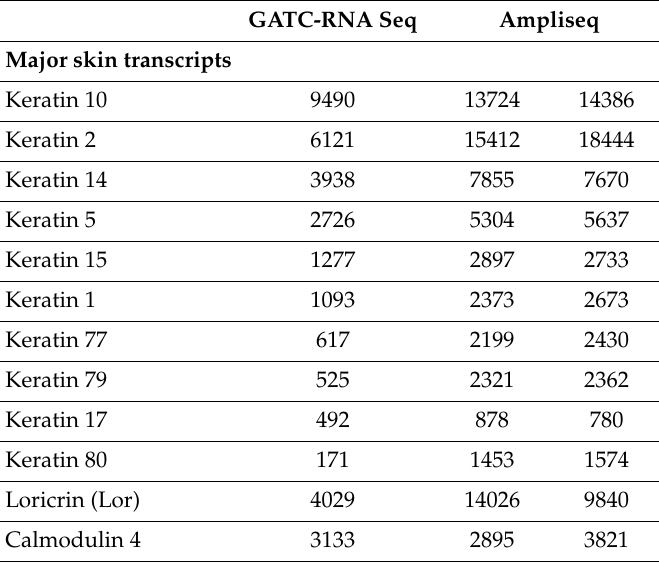
Table 3. Levels of major transcripts in the ears of BALB / c mice. The number of normalized reads for each of the proteases is given in actual numbers (obtained from GATC biotech and SciLife Thermo Fisher Ampliseq analyses). Two independent Ampliseq runs were performed. Note that the levels of Mcpt4 were very high in the skin compared to the peritoneal